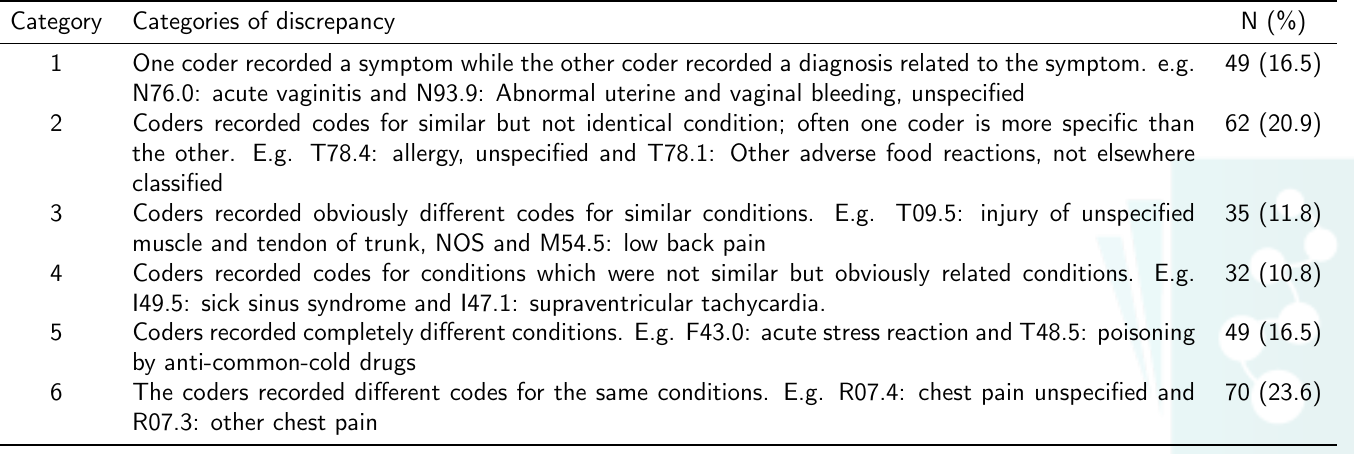
Table 3: Proportion of cases in each category of discrepancy on ICD codes showed disagreement between hospital coder and